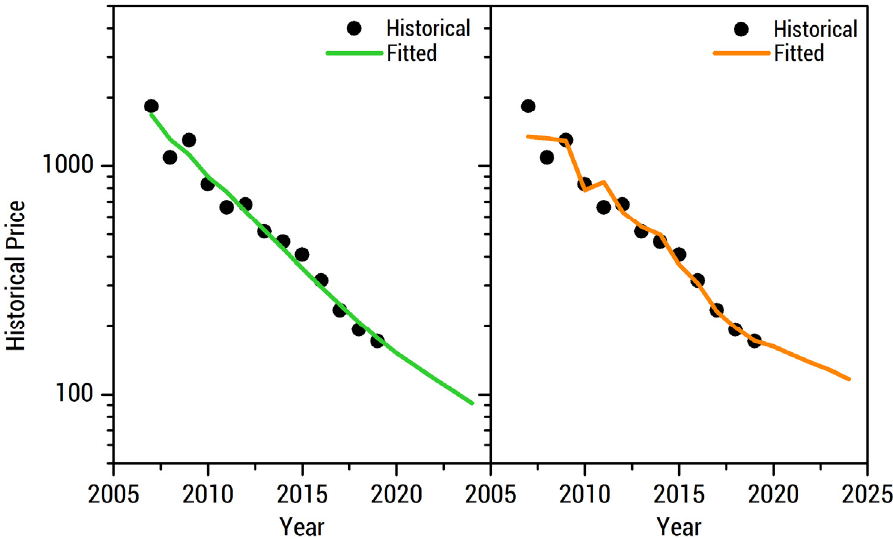
Figure 5. Li-ion NMC battery pack historical prices and predicted prices according to a two-factor ( left ) and four-factor ( right ) learning curve model. The two-factor model falls below the 100 USD / kWh price point in agreement with expert predictions. The four-factor model is overfitted and may lead to inaccurate results.